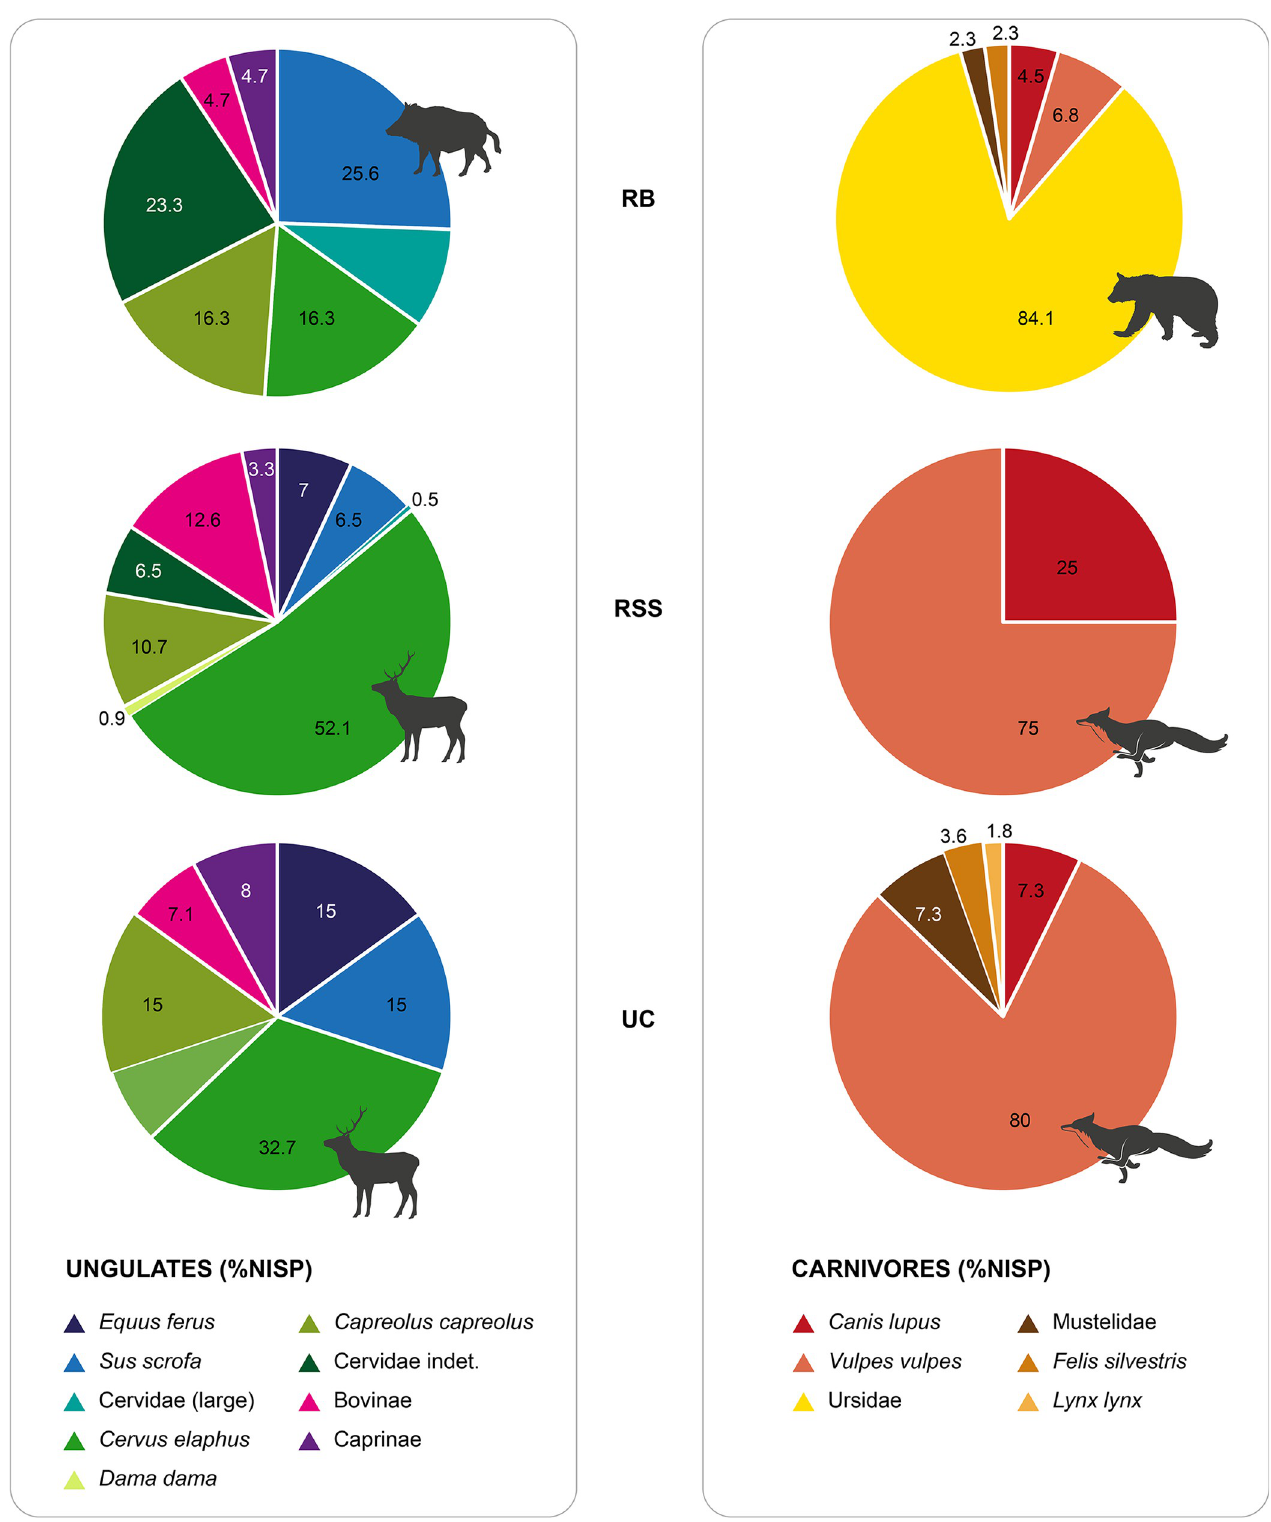
Fig 2. %NISP of Ungulates and Carnivores obtained from the zooarchaeological analysis. Percentages of Ungulates (%NISP) and Carnivores obtained from the morphological determination of the faunal assemblage for RB (Riparo del Broion), RSS (Roccia San Sebastiano cave) and UC (Uluzzo C Rock Shelter).